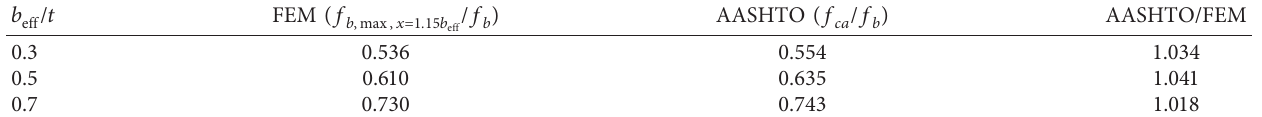
/ t � 0 . eff , and y � 0). eff